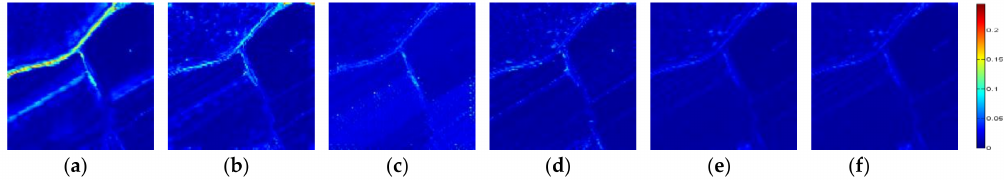
Figure 4. SAM maps of the enhanced images for Salinas dataset: ( a ) MAP; ( b ) CNMF; ( c )